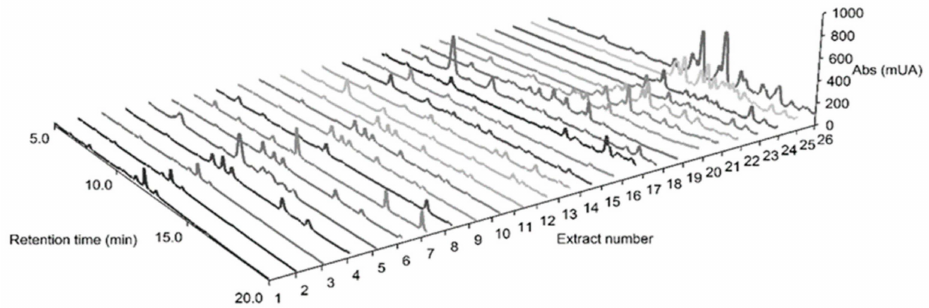
Figure 3. High-performance liquid chromatography (HPLC) fingerprinting (5–20 min section) of Plectranthus spp. extracts (10 mg / mL) obtained at 270 nm, chemical structures of their predominant constituents and correspondent retention times (Rt, min). Abs: absorbance.